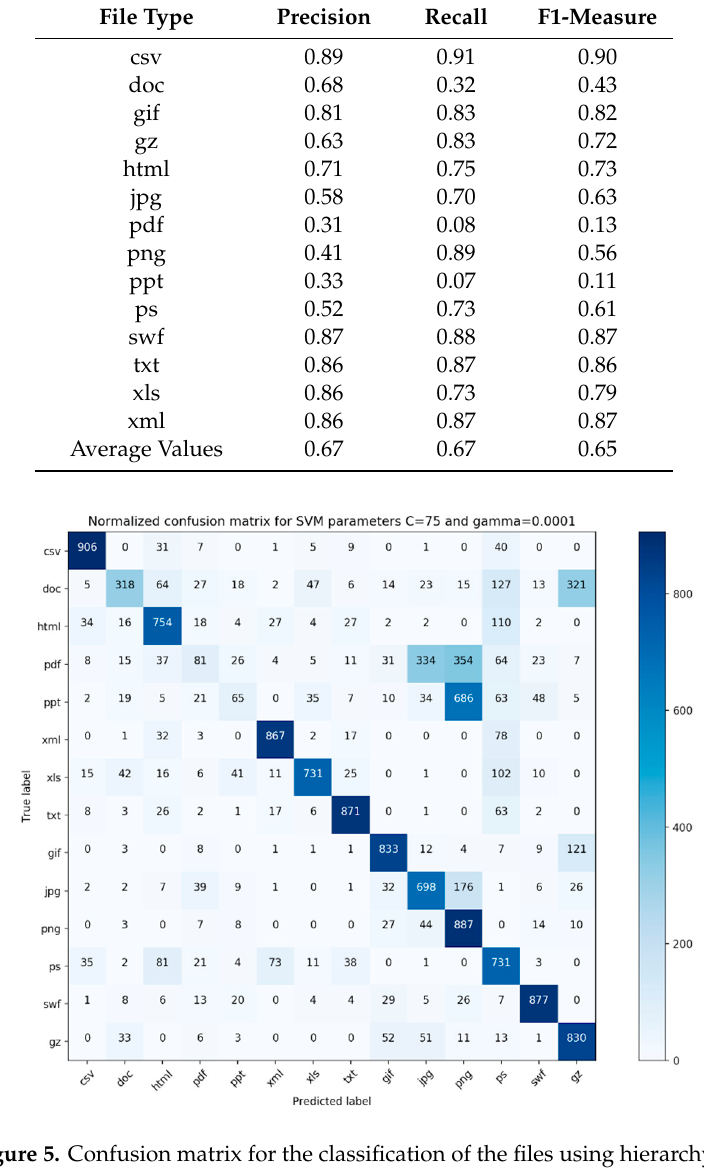
Table 5. Classifier results for hierarchy 2.